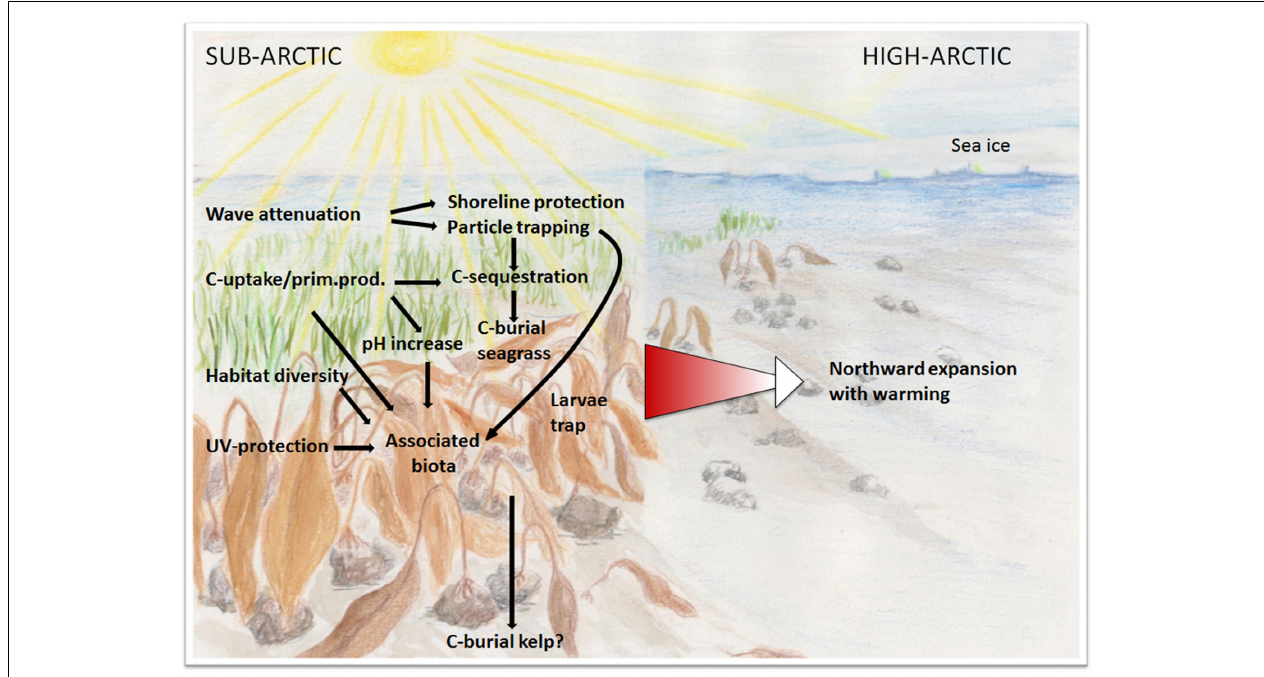
FIGURE 2 | Conceptual illustration of hypothesized northward expansion of vegetated ecosystems and associated ecosystem functions and societal services as warming reduces sea-ice cover and increases solar radiation to coastal arctic seafloors. Many of